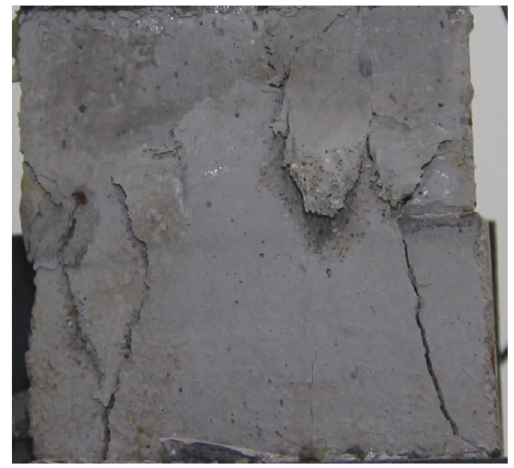
Figure 23. Photograph of a specimen showing surface spalling.